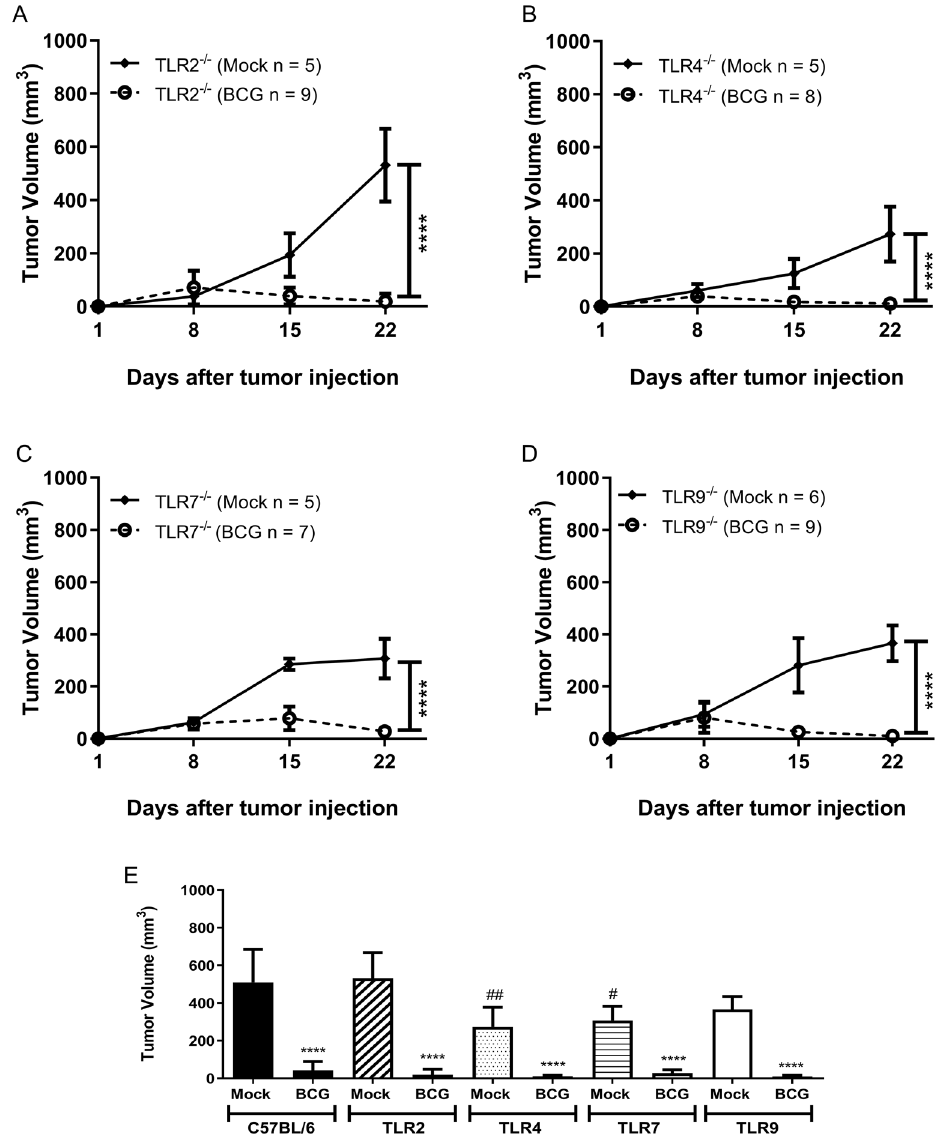
Figure 5. TLR2, TLR4, TLR7, and TLR9 receptors do not interfere in tumor regression in response to BCG treatment. C57BL/6 WT, TLR2 −/− , TLR4 −/− , TLR7 −/− and TLR9 −/− mice were submitted to the subcutaneous tumor model and BCG treatment. Tumor growth curves are shown for TLR2 −/− ( A ), TLR4 −/− ( B ), TLR7 −/− ( C ) and TLR9 −/− ( D ). The final volumes (day 22) are shown in Figure ( E ). Data represents mean and standard deviation from the results of at least two independent experiments. C57BL/6 WT data represents the summary of control animals from all in vivo experiments comparing WT and KO mice. *Statistically significant compared to the respective untreated control, **** P ≤ 0.0001. # Statistically significant compared to C57BL/6 WT mock not treated, # P ≤ 0.05, ## P ≤ 0.01, #### P ≤